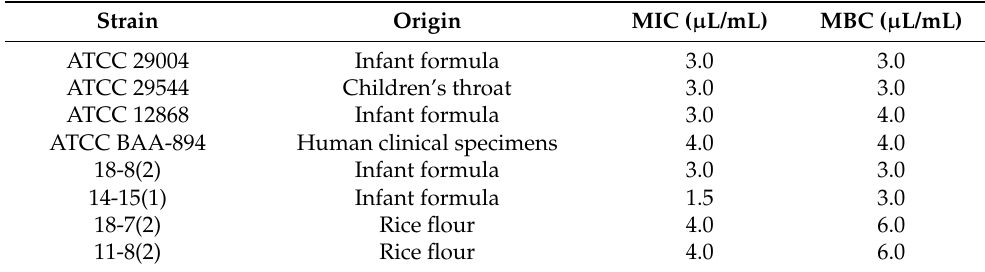
Table 1. MIC and MBC of LC-EO toward eight strains of C. sakazakii